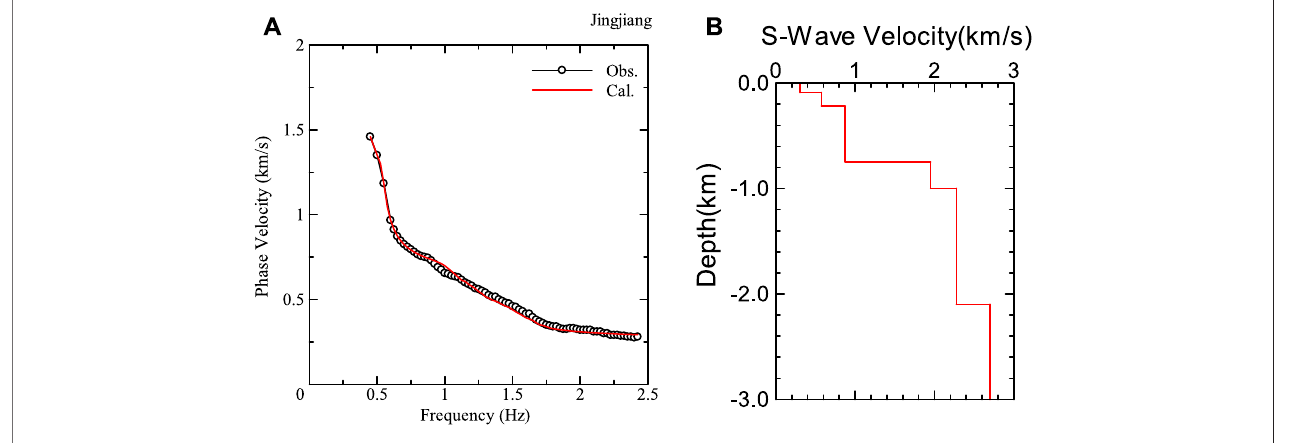
FIGURE 3 | Dispersion curve (A) and inversion S-wave velocity structure (B) .